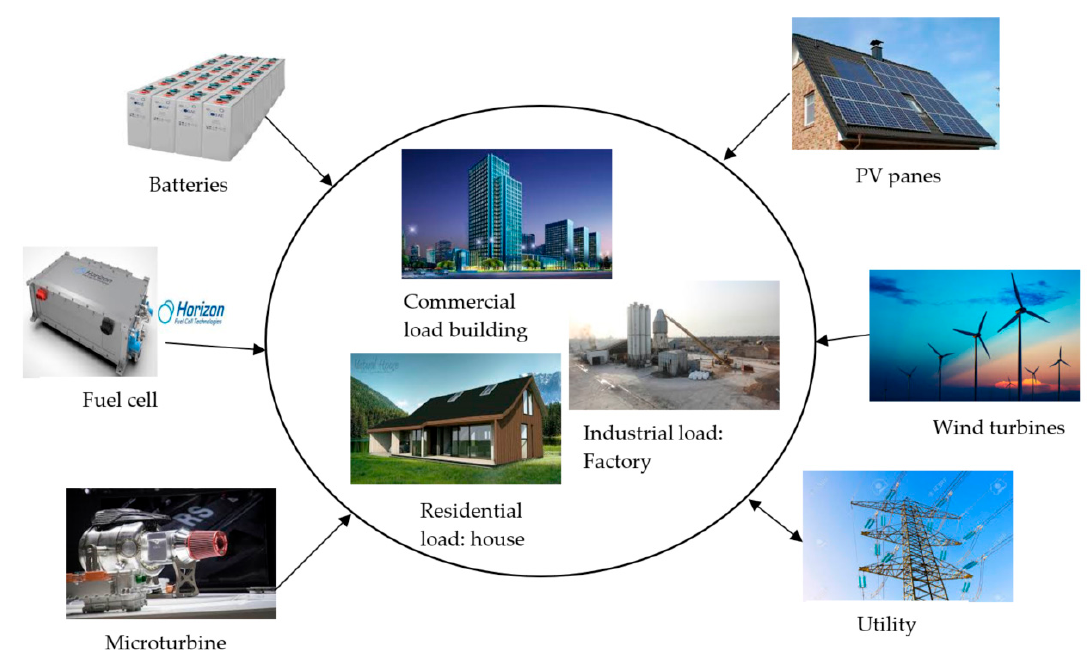
Figure 1. Grid-connected Microgrid .